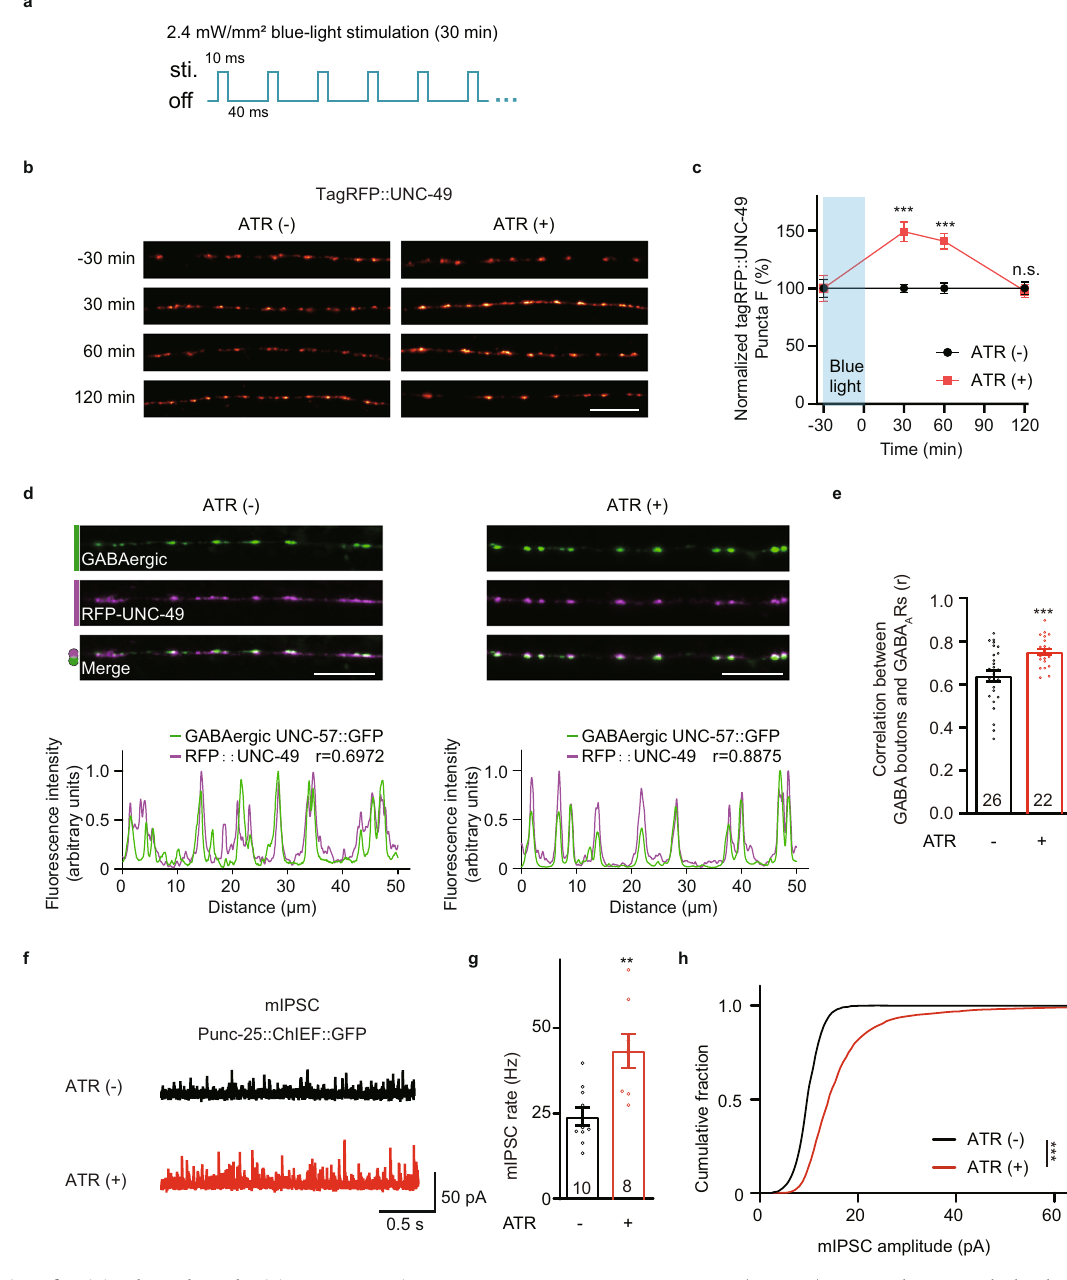
postsynaptic GABA A Rs (magenta) were used to assess the localization of GABA A Rs at inhibitory synapses. Representative images ( d -top, scale bar, 10 μ m), corre- sponding line scan curve ( d -bottom), and mean Pearson ’ s correlation coef fi - cients+/ − SEM ( e , Ns repr e sent the number of animals tested) are shown. Two- tailed and unpaired Student ’ s t -test. *** p <0.001. f – h Endogenous inhibitory synaptictransmissionwasassessedbyrecordingmIPSCsfrombody-wallmusclesin transgenicanimalsexpressingachannelrhodopsinvariant(ChIEF)intheGABAergic motorneurons(under unc-25 promoter)afterblue-lightstimulationwithorwithout all-trans retinal (ATR). Representative mIPSC traces ( f ), mIPSC rates ( g , Data are presented as mean values+/ − SEM, Ns represent the number of animals tested.), and the cumulative fraction of mIPSC amplitude ( h ) are shown. Two-tailed and unpaired Student ’ s t -test for g and Kolmogorov – Smirnov test for h . ** p <0.01, *** p <0.001. For c , e , g , h , source data are provided as a Source Data fi